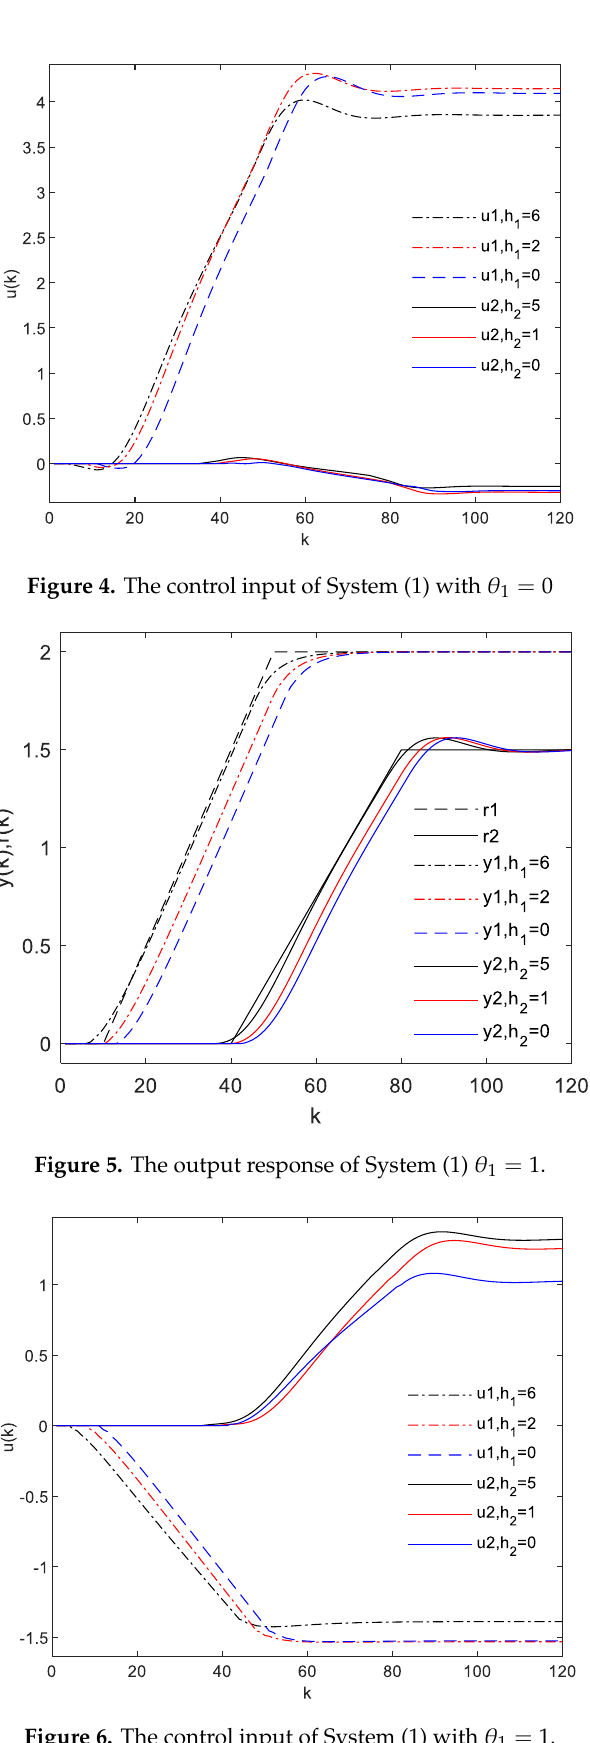
Figure 3. The output response of System (1) with